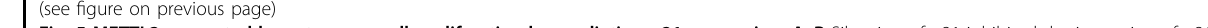
Fig. 5 METTL3 promoted breast cancer cell proliferation by mediating p21 expression. A , B Silencing of p21 inhibited the increasing of p21 induced by METTL3 knockdown in both RNA and protein level in SUM-1315 and MCF-7 cells. The relative RNA level was calculated by the 2 − ΔΔ Ct method and normalized based on β -actin. The average mRNA level of p21 in the shNC group was set as 1. C – F Suppression of p21 alleviated the inhibitory effects on cell proliferation and colony formation mediated by METTL3. G IHC of subcutaneous xenograft tumors showed that a signi fi cant increase in the positive rate of Ki-67 while a signi fi cant decrease in the positive rate of p21 in the METTL3 overexpression group. H The protein level of METTL3 in the tumors of mice treated with metformin decreased than those with PBS, while the protein level of p21 increased in the metformin group. shNC, scramble control; shM3/shMETTL3-2, METTL3 knockdown; shM3 + siP21, METTL3 knockdown cells transfected with p21 siRNA; oeNC, negative control; oeNC-Met, oeNC-Met negative control group treated with metformin; oeMETTL3, METTL3 overexpression; oeMETTL3-Met, METTL3 overexpression group treated with metformin. Data represented the mean ± SD, * p < 0.05, ** p < 0.01 vs. shMETTL3-2